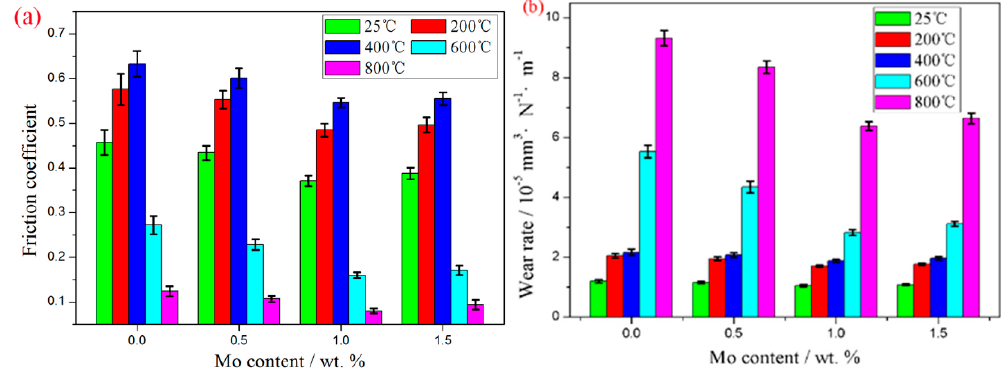
Figure 2. The variation trends of the friction coefficient and wear rate with the Mo content at different temperature: ( a ) friction coefficient and ( b ) wear rate.